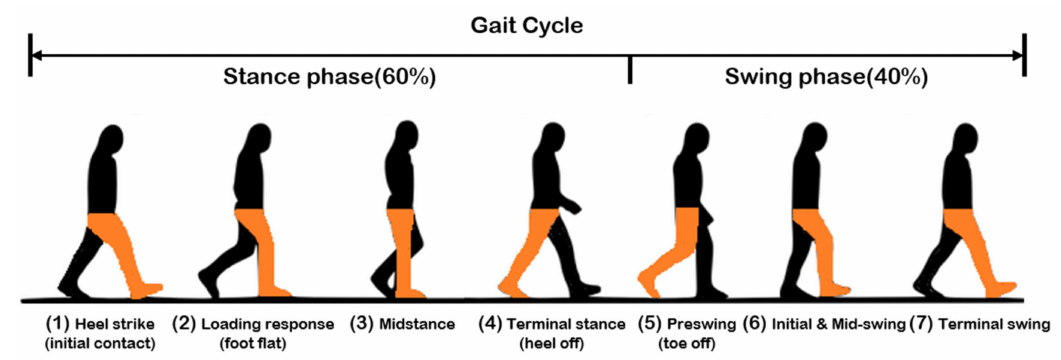
Figure 3. A complete gait